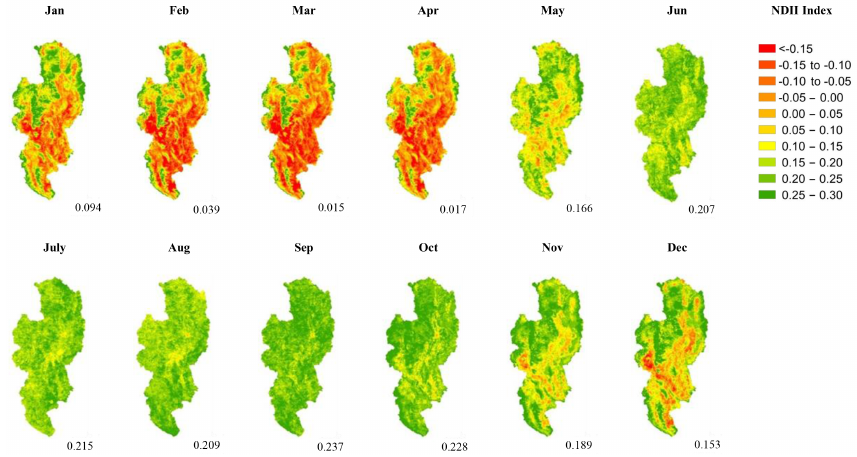
Figure 3. Monthly average NDII values for the UPRB in 2004. The green colour indicates an NDII between 0.15 and 0.30, yellow between 0 and 0.15, orange between − 0.15 and 0, and red an NDII< − 0.15) representing relatively high, medium, low, and very low root zone moisture content.